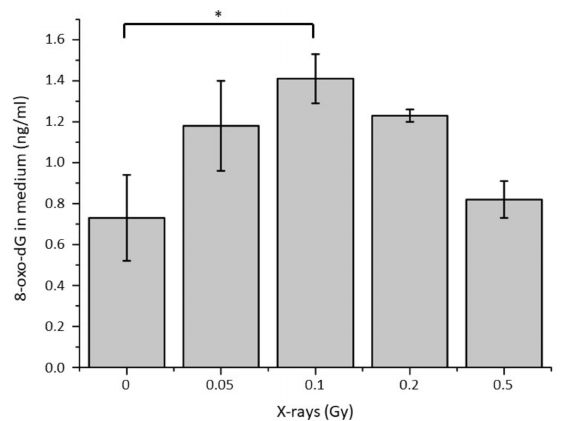
Figure 2. Quantification of 8-oxo-dG in the conditioned medium of chondrosarcoma cells irradiated with different doses of X-rays. (* = p <